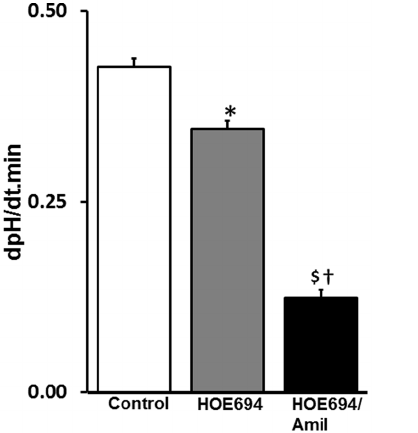
Figure 12. Effect of HOE694 on intracellular pH (pHi; proton extrusion) in crypt gland from distal colon. Rate of change in pHi in presence of extracellular HCO 3 was examined in the presence ( HOE694 ) and absence ( Control ) of 1 m M HOE694. Rate of pHi in the presence of HOE694 was also measured in additional presence of 0.1 mM amiloride ( HOE694/Amil ). * p , 0.0003 - compared to control; $ p , 0.0001– compared to control; { p , 0.0001– compared to HOE694.